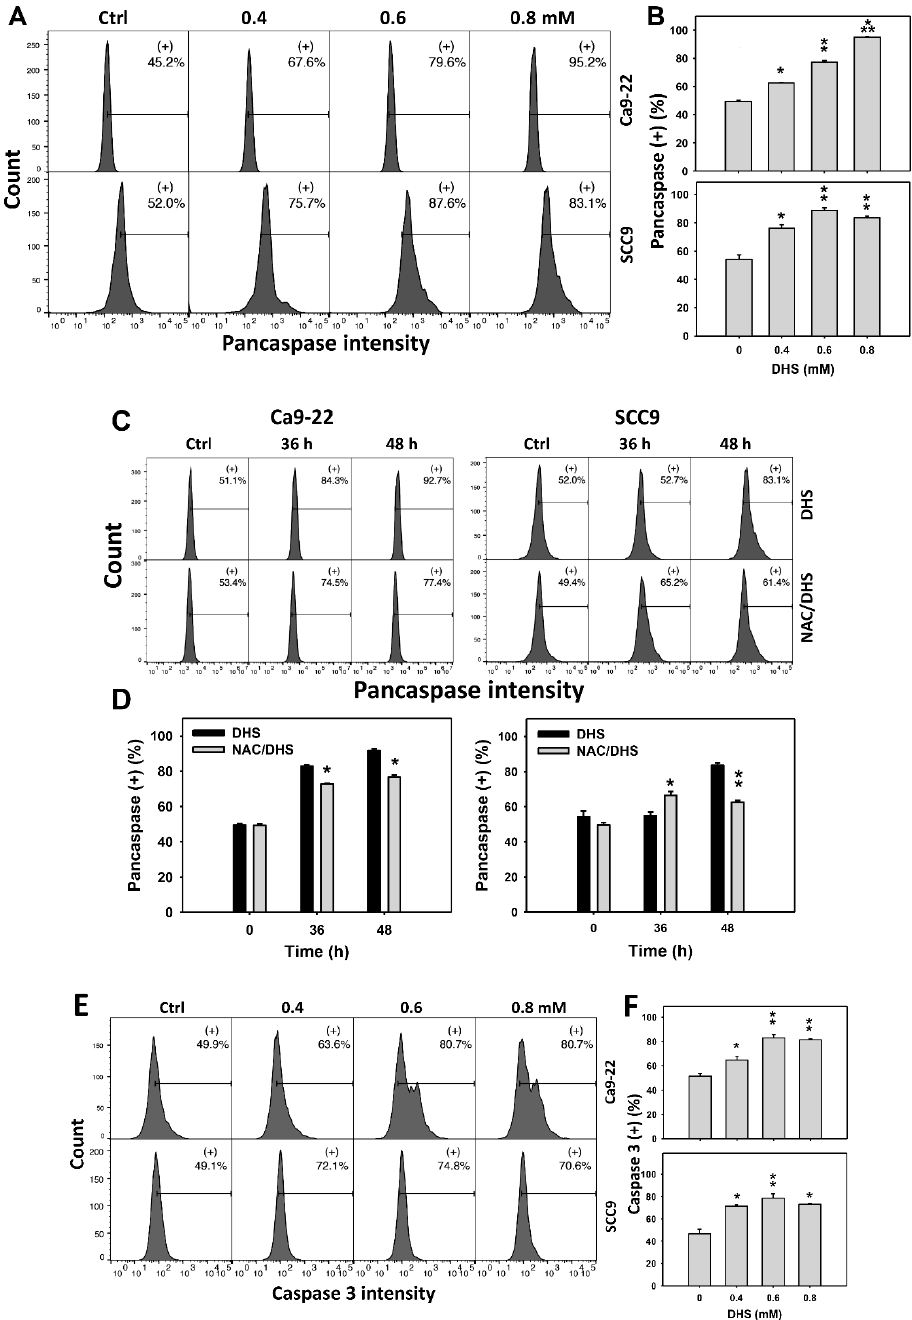
Figure 4. DHS effects on caspase-based apoptosis of oral cancer cells. ( A , B ) Representative pancaspase patterns of DHS- treated oral cancer cells. Cells (Ca9-22 and SCC-9) were treated with vehicle (containing 0.08% DMSO), 0.4, 0.6 and 0.8 mM DHS for 48 h. (+) indicates the high pancaspase activity populations. ( C , D ) Alleviation of the pancaspase changes of DHS-treated oral cancer cells by NAC. Cells were pretreated with NAC (4 mM, 1 h) or not, and then they were treated with the vehicle and 0.6 mM DHS for 0, 36 and 48 h. ( E , F ) Representative caspase 3 patterns of DHS-treated oral cancer cells. Data = means ± SDs ( n = 3). *, ** and *** indicate significant differences between ( A , B ) DHS and control and ( C , D ) DHS and NAC/DHS ( p < 0.05, 0.01, and 0.001, respectively). A positive control for pancaspase-detected apoptosis of oral cancer cells is provided in Supplementary Figure